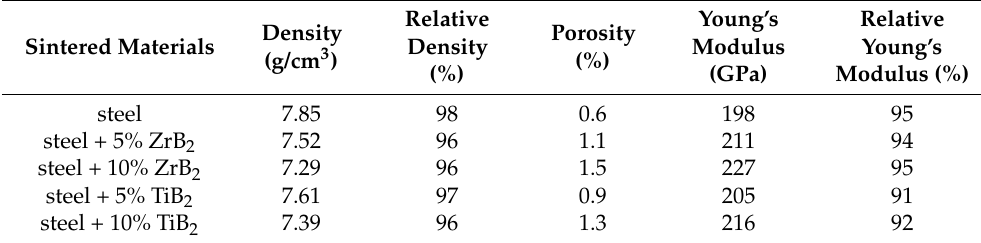
Table 1. Properties of the materials formed by SPS.